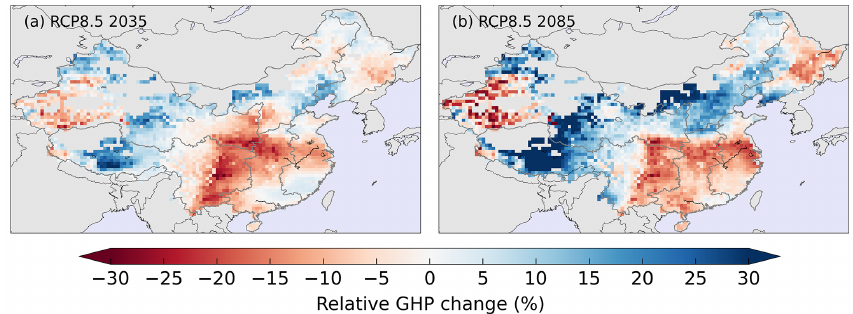
Figure 4. Medians of relative changes in the annual mean GHPs for 2020–2050 (a) and 2070–2099 (b) compared to the historical period (1971–2000) across the ensemble of GCM-GHM combinations under RCP8.5.